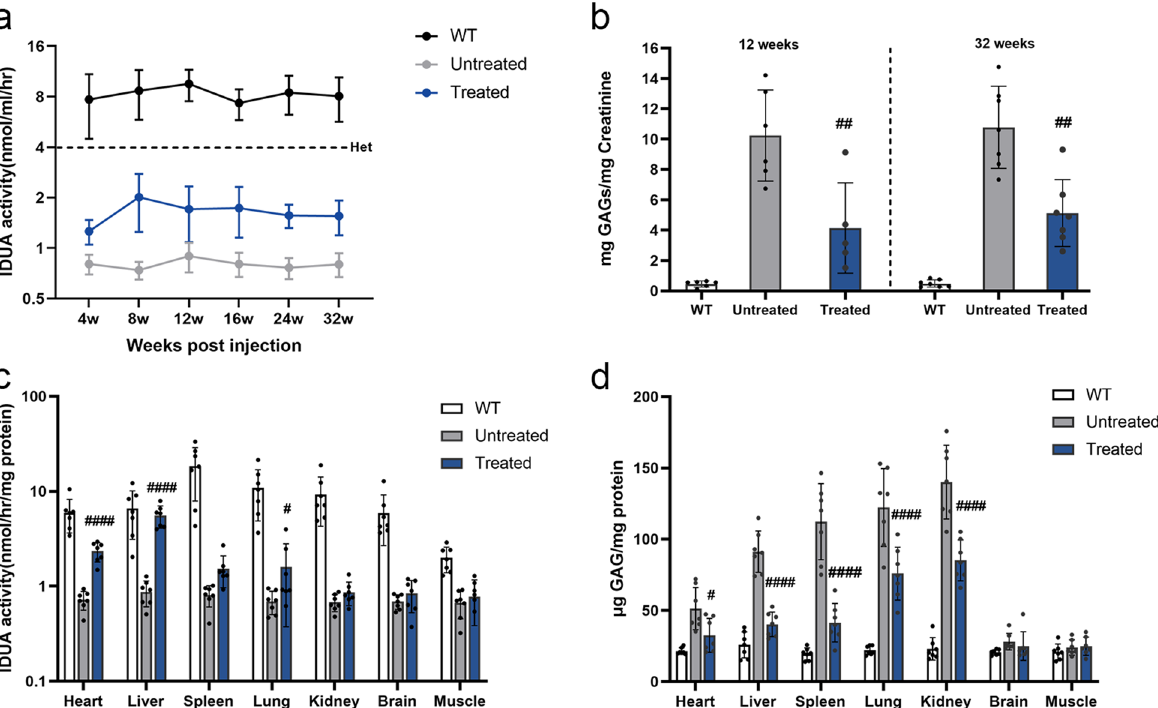
Fig. 2 In vivo base editing enables sustained biochemical correction in MPS IH mice. a Time course of serum IDUA activity was measured 4 weeks after injection. Dotted line indicates the serum IDUA activity of heterozygous MPS IH mice. Mean SD are shown, n 7 per each group. b Urine ± = GAGs was detected 12 weeks and 32 weeks after injection. At 12 weeks, WT mice ( n 6), untreated MPS IH mice ( n 6), treated MPS IH mice ( n 5). = = = At 32 weeks, n 7 per each group. Mean SD are shown. Comparison between treated and untreated groups, ## p < 0.01, one-way ANOVA analysis = ± with Tukey’s post-hoc test. c Tissue IDUA activity was detected in various tissues 32 weeks after injection. d Tissue GAGs storage was detected in various tissues 32 weeks after injection. ( c, d ) WT mice ( n 7) and untreated MPS IH mice ( n 7) were included as control. Treated MPS IH mice = = ( n 7). Mean SD are shown. The treated MPS IH mice were compared with the untreated MPS IH mice, # p < 0.05, #### p < 0.0001, one-way ANOVA = ± analysis with Tukey’s post-hoc